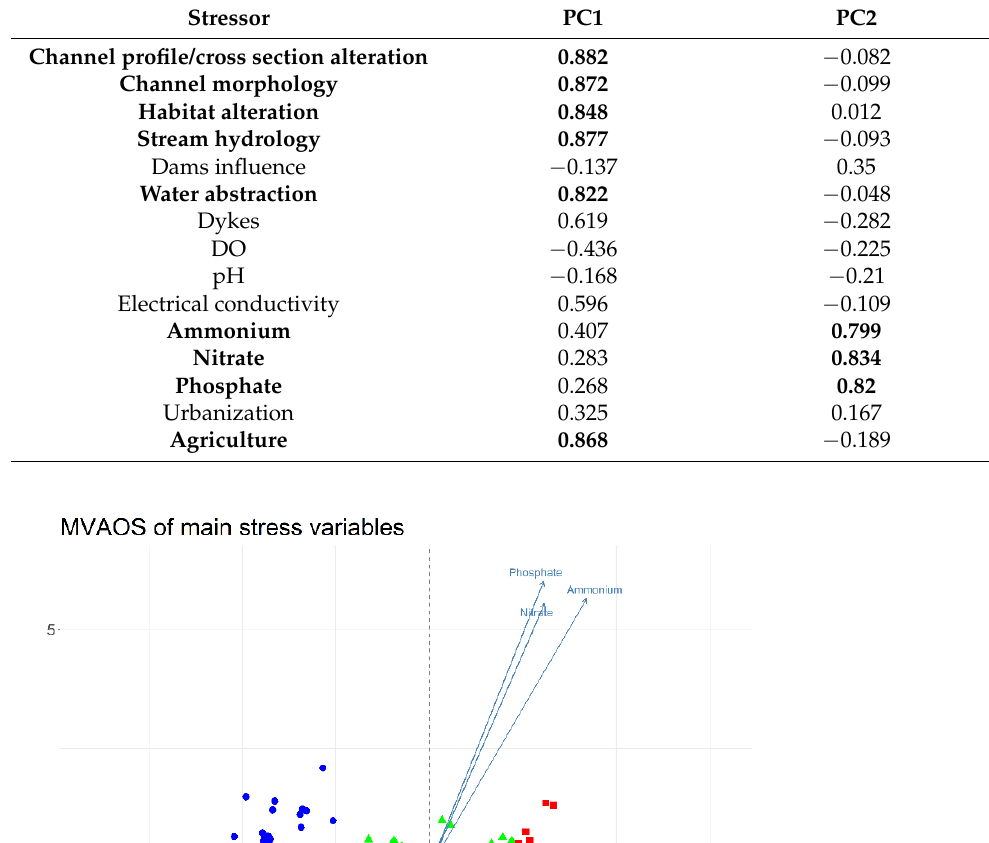
Table 2. Correlations between the environmental variables and the first two principal components. Values > 0.7 (in bold) indicate which variables are retained for further analysis.